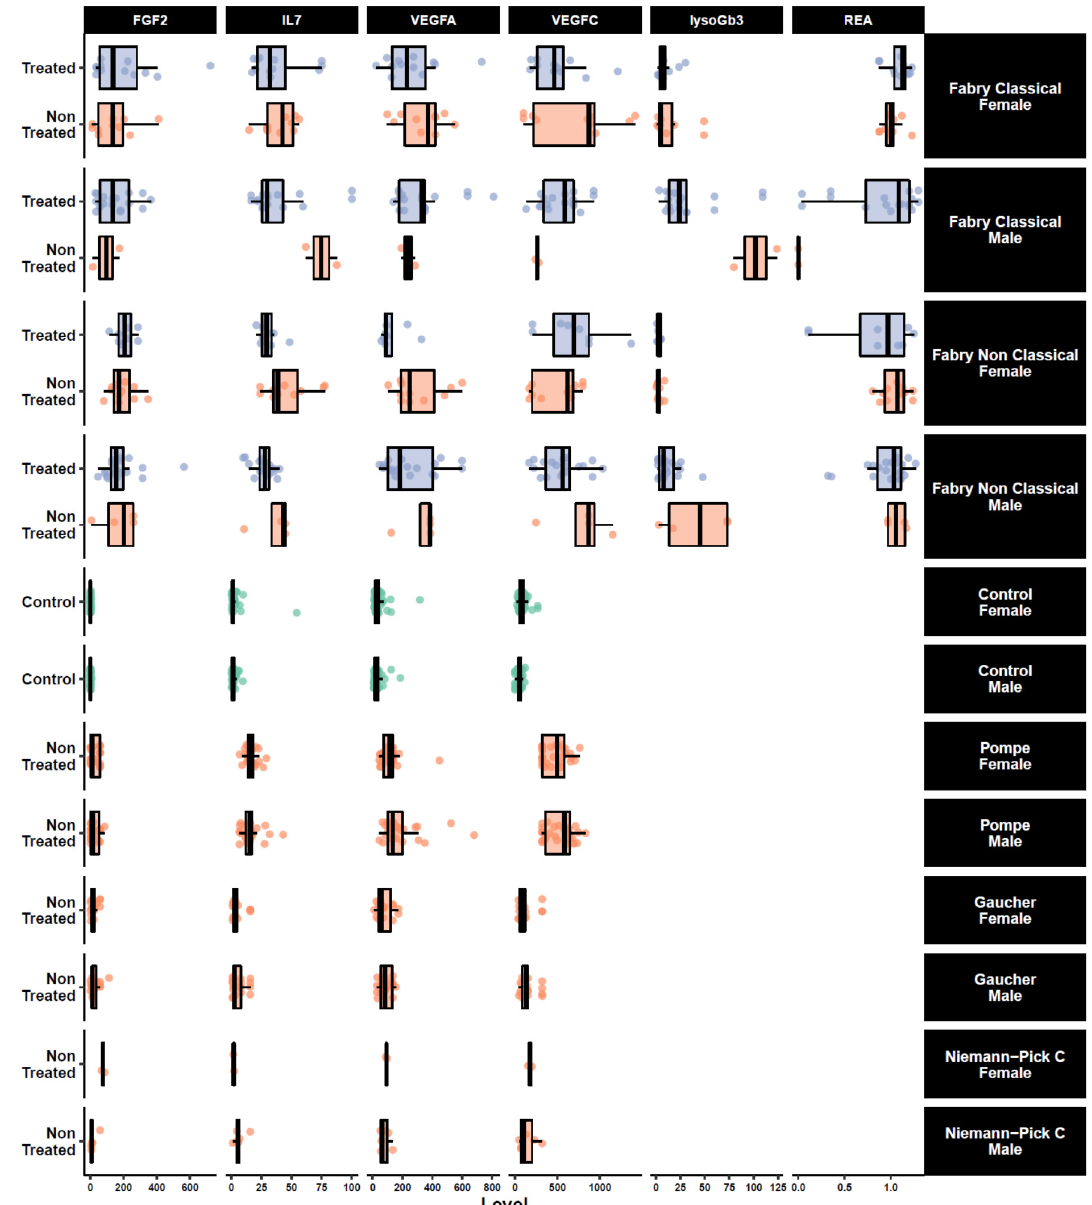
Figure 3. Boxplots of selected top significant proteins between sex-related controls and Fabry samples and their expression in phenotype-, sex-, and treatment-related Fabry, along with three other lysosomal diseases; Gaucher, Niemann–Pick Type C, and Pompe. FGF2; fibroblast growth factor 2, IL7; interleukin 7, VEGFA; vascular endothelial growth factor A, VEGFC; vascular endothelial growth factor C, REA; residual enzymatic activity, lysoGb3; globotriaosylsphingosine.